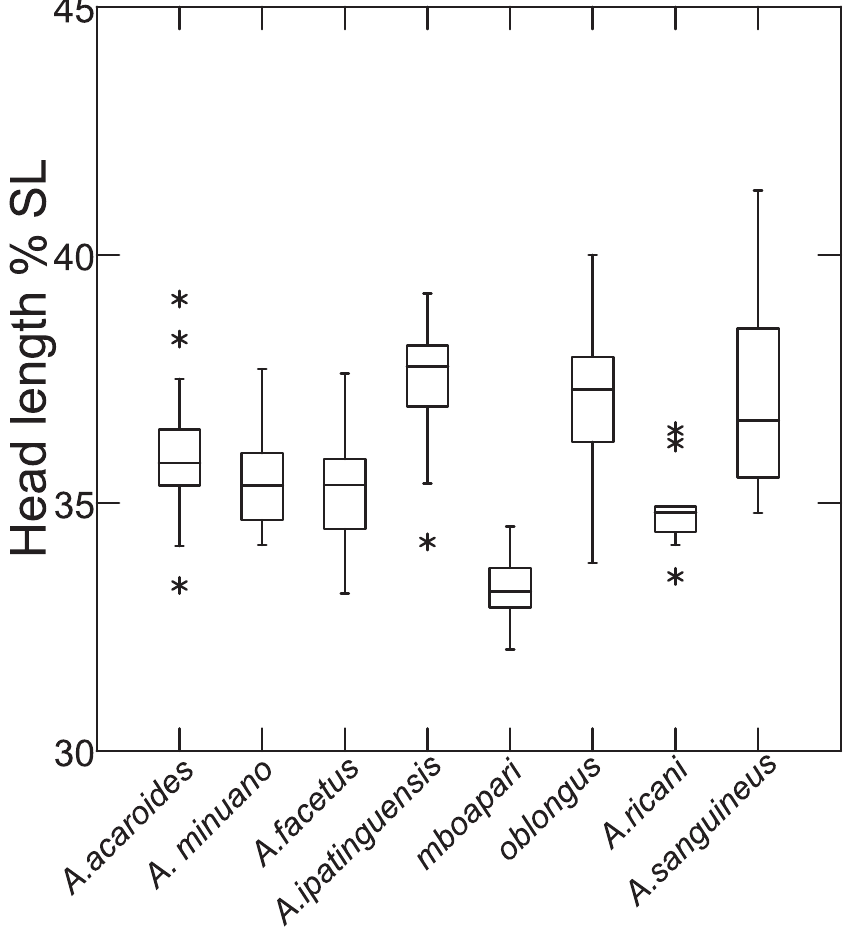
Fig 3. Box and whisker plot of last dorsal-fin spine length in per cent of SL in nominal species Australoheros capixaba , A . A . mattosi , and A . tavaresi